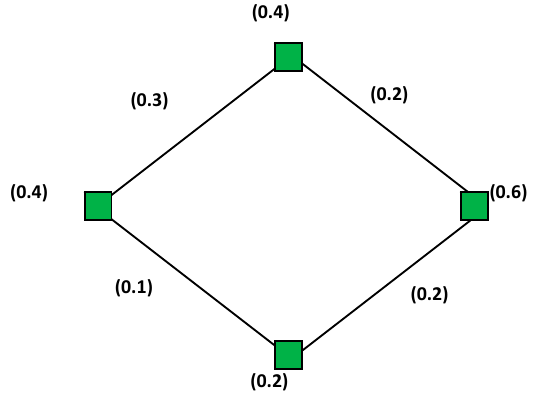
Figure 1. Fuzzy graph (FG) compatible with Definition